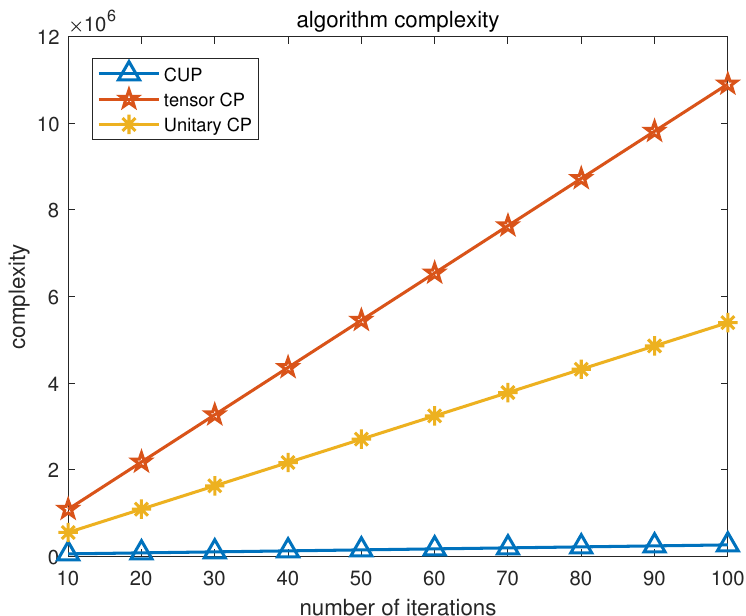
Figure 4. Complexity comparison and